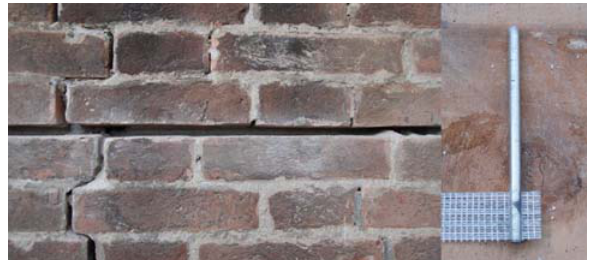
Figure 7: armed stitching along the mortar joints to close the cracks